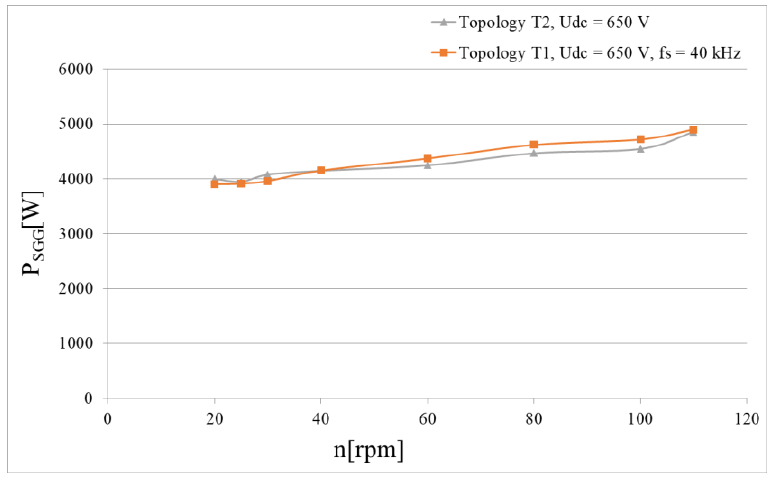
Figure 17. Total power losses in the gearbox drive motor and the generator PSGG.